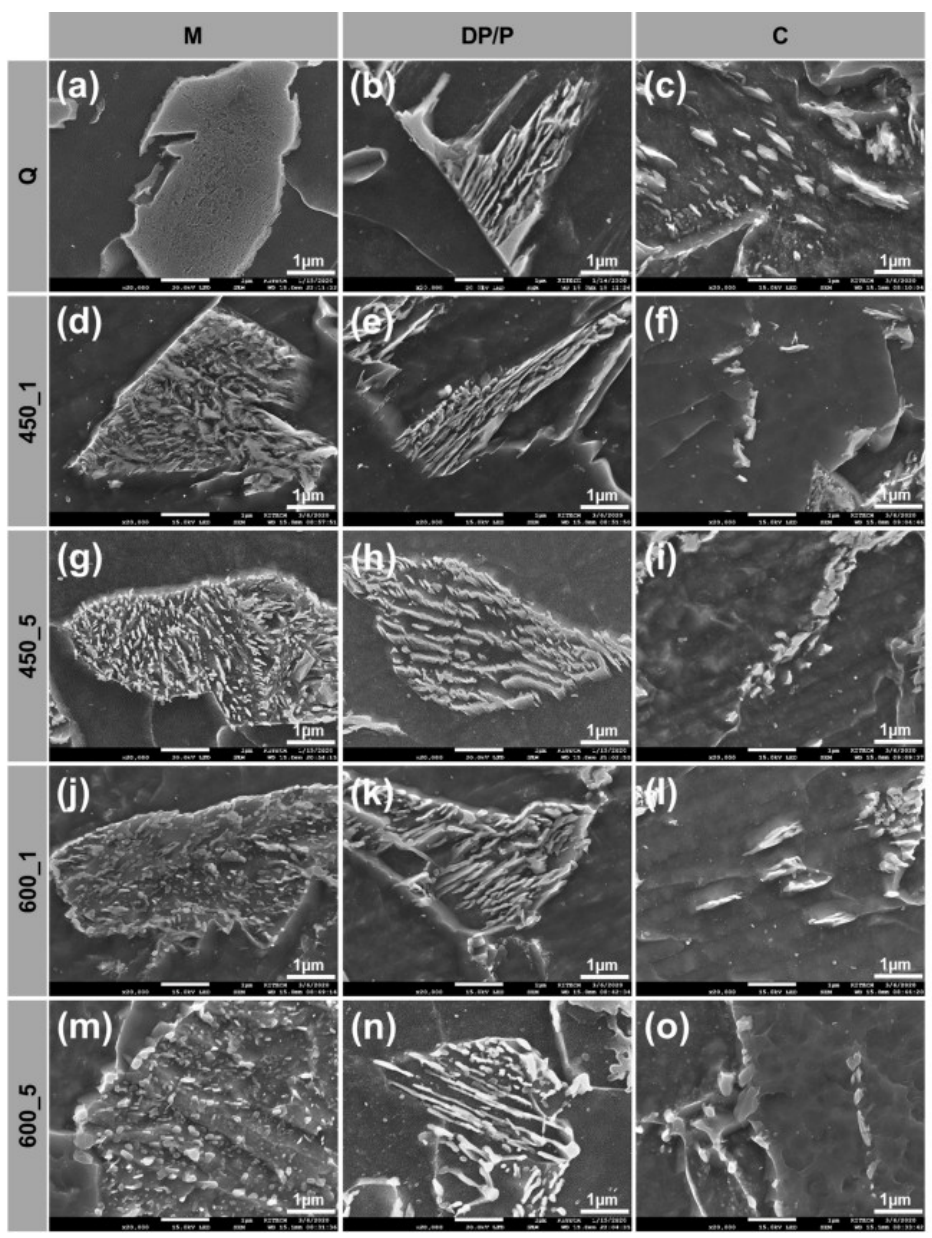
Figure 6. Scanning electron micrographs of ( a , d , g , j , m ) martensite, ( b , e , h , k , n ) degenerated pearlite/pearlite, ( c , f , i , l , o ) cementite according to tempering conditions in the MC (−4.6 °C/s) location: ( a – c ) Q, ( d – f ) 450_1, ( g – h ) 450_5, ( j – l ) 600_1, ( m – o )